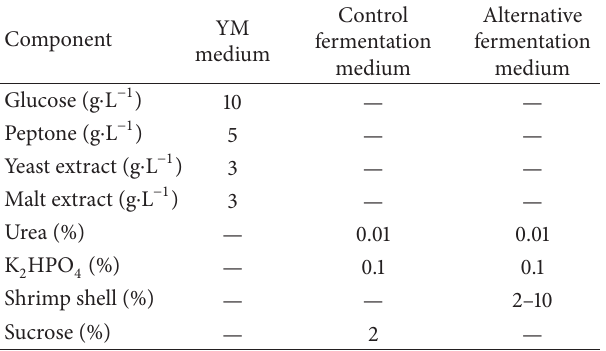
Table 3: Physicochemical characterization of the shrimp shell and the SSAE used as a substrate for fermentation in the production of xanthan gum by three strains of Xanthomonas campestris